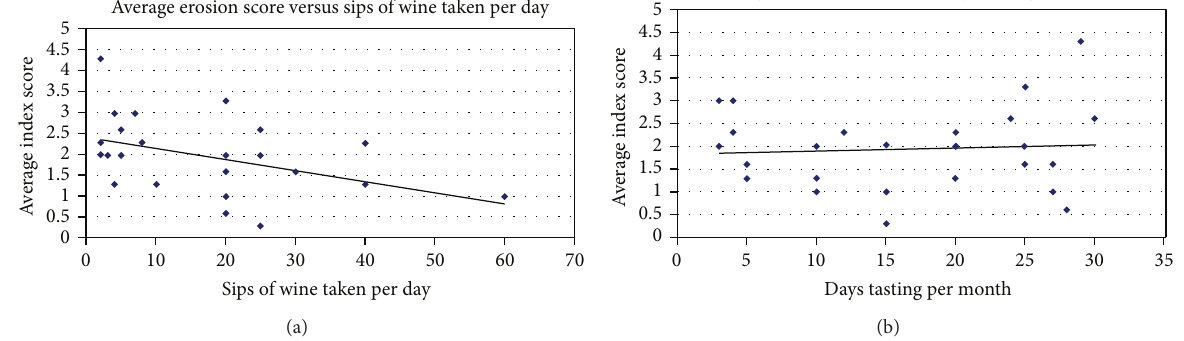
Figure 1: Scatter graph of dental erosion and number of wine sips. A line of best fit of the average erosion index score against the number of tasting sips per day (a) or number of days per months (b) indicates a nonlinear relationship.